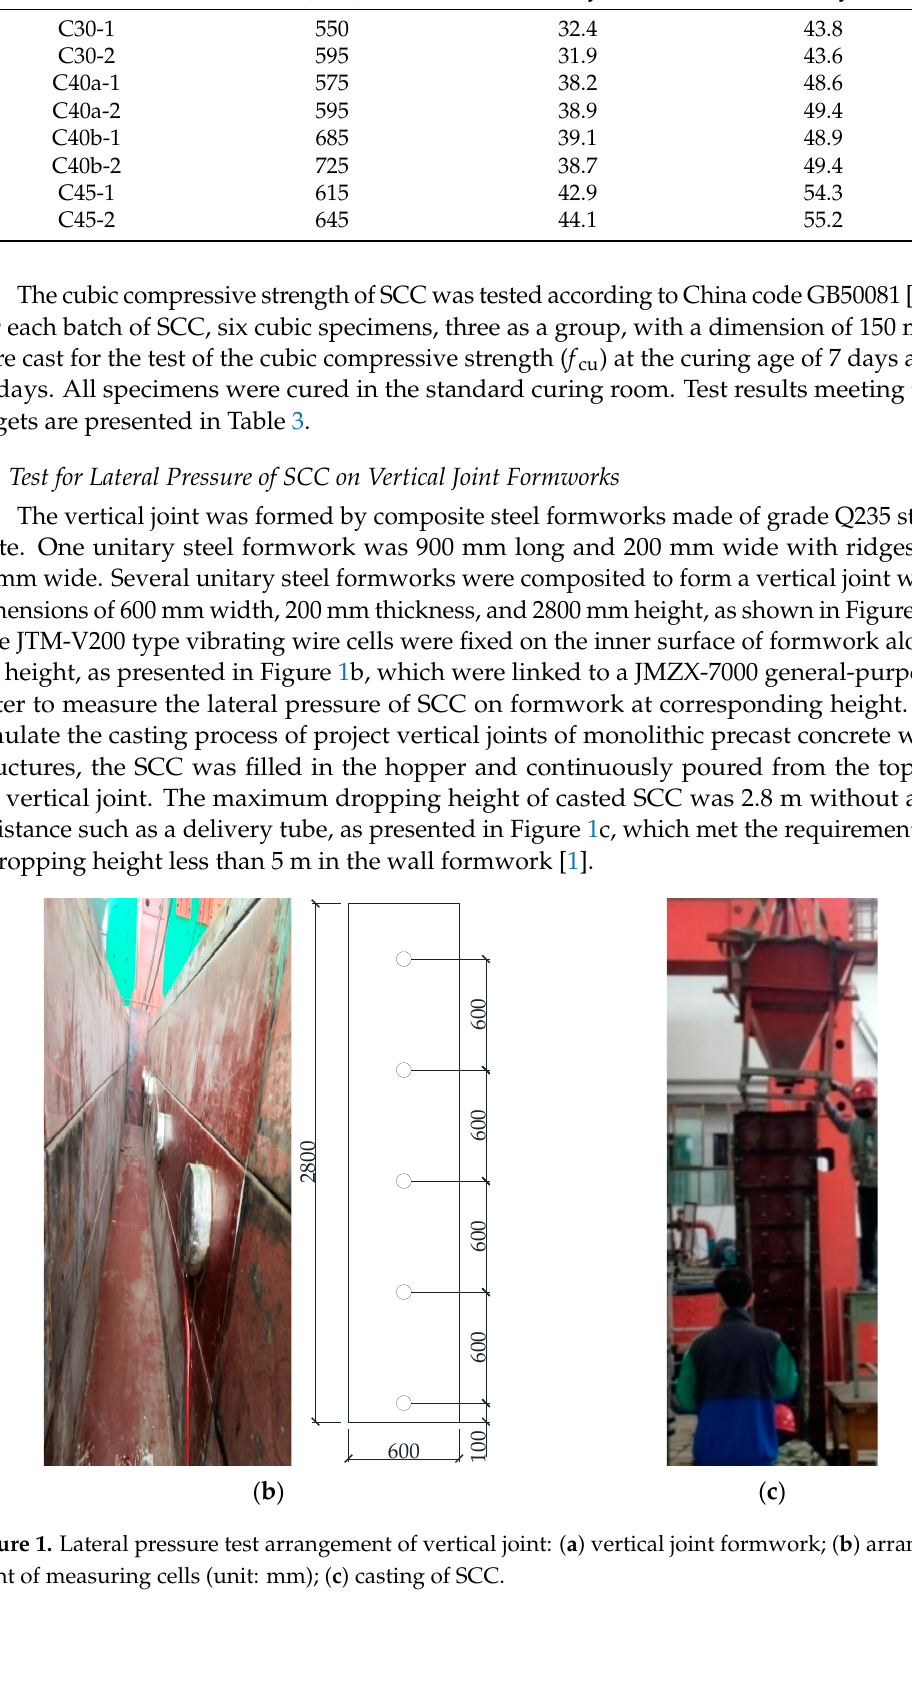
Table 3. Test results of slump-flow and cubic compressive strength of SCC. Group No.